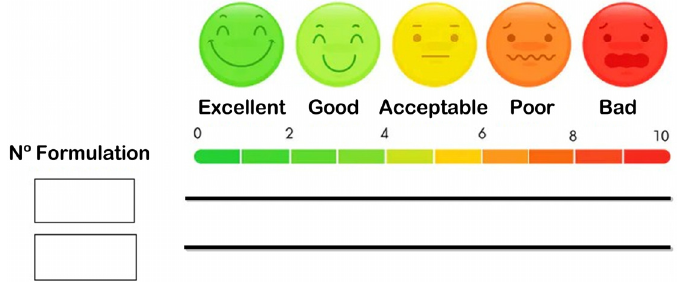
Figure 2. Visual analogue scale used for the in vivo assay of palatability.